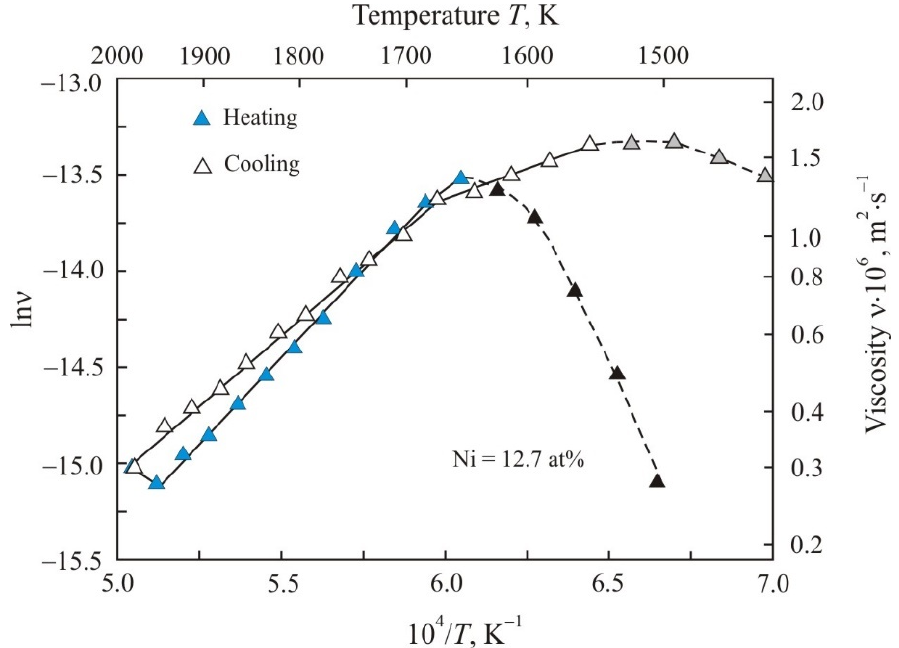
Figure 3. Kinematic viscosity on a natural logarithmic scale ln ν as a function of the inverse absolute temperature T − 1 upon heating to maximum temperature T max = 1985 K and cooling the Fe 72.5 − x Ni x Cu 1 Nb 2 Mo 1.5 Si 14 B 9 alloys with Ni content 12.7 at. %. The viscosity should decrease with increasing temperature. However, in the low- temperature regions, which are marked with gray and black symbols, the viscosity increases. This temperature region corresponds to the mushy zone, in which the liquid and solid phases coexist [8]. An increase in the logarithmic decrement and calculated viscosity with increasing temperature is caused by an increase in the volume of the liquid phase in the measuring cup. Melts with a Ni content of 2.5 and 6.3 at. % begin to behave like the Arrhenius type at temperatures above 1560 K both at the heating and cooling stages. The melt with a Ni content of 12.7 at. % flows according to the Arrhenius equation when heated above 1685 K, and at the cooling stage, this type of viscous flow takes place down to a temperature of 1560